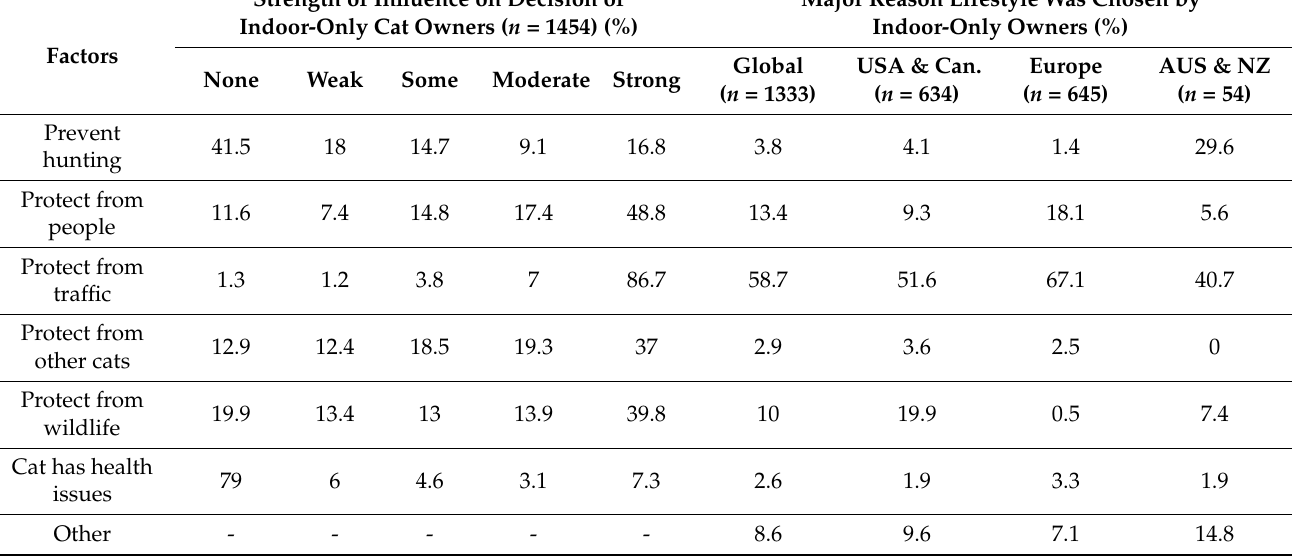
Table 6. The percentages of indoor-only cat owners ( n = 1454) reporting different influence strength of factors on their decision to give their cats an indoor-only lifestyle and the major reasons for choosing an indoor-only lifestyle globally ( n = 1333), then broken down by